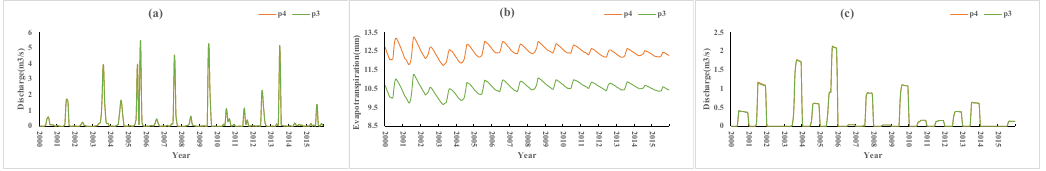
Figure 11. P4 vs. P3 simulation results: ( a ) surface runoff, ( b ) evapotranspiration, ( c ) farmland runoff.